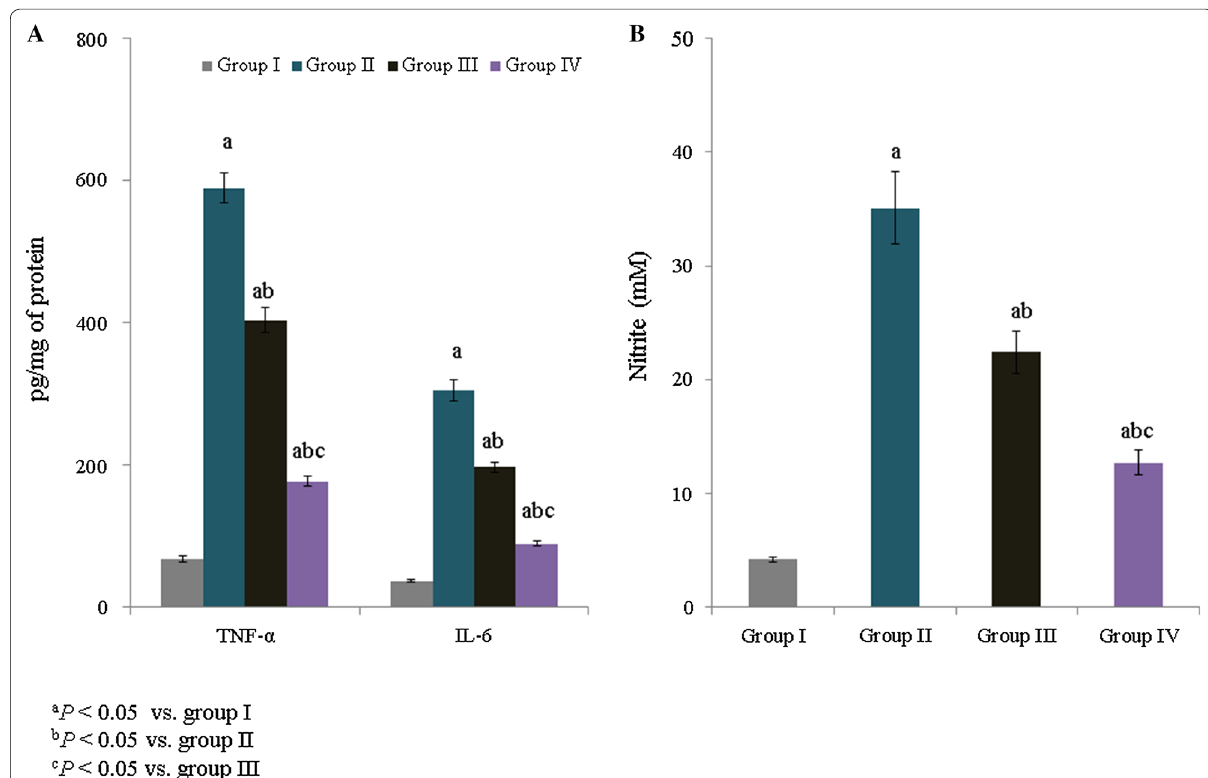
Fig. 2 Effect of E. hirta extract on tumor necrosis factor alpha (TNF-α), interleukin 6 (IL-6), and nitric oxide (NO) levels in neonatal asthmatic rats. A TNF-α and IL-6 levels are expressed as pg/mg of protein. B NO is expressed as mM. Experimental data are given as the mean